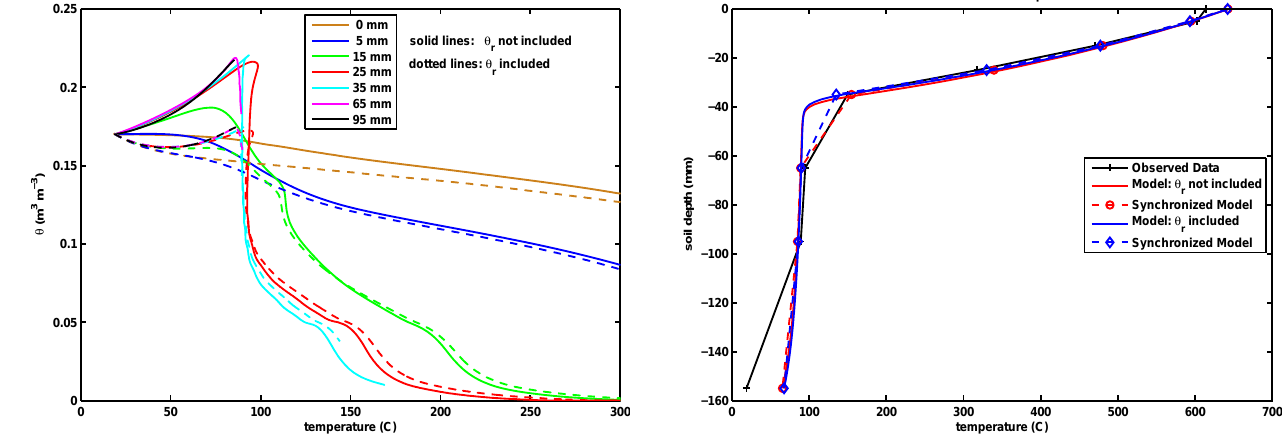
Figure 14. Comparison of the final modeled and measured tempera- ture profiles at the completion of the 70min Palousse B Wet heating experiment. Because the data shown in the measured profile (black) are not precisely coincident in time, the full model results (solid red and blue lines) were sub-sampled in synchrony in time (and coincide in space) with the observations. These time-synchronized model profiles are shown as dashed red and blue